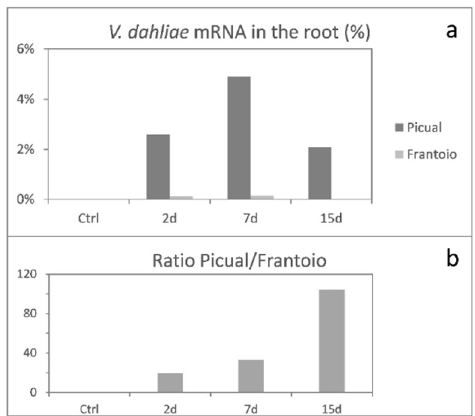
Figure 1. Accumulation of Verticillium dahliae transcripts in the roots of inoculated plants during early stage of infection in the susceptible variety ‘Picual’ and tolerant ‘Frantoio’. The percentage of the total paired-end reads that aligned with V. dahliae genes is represented for each time point. Only the paired-end reads that aligned both ends unequivocally at the correct distance with fungal genes are represented ( a ). Ratio of Picual/Frantoio percentage of reads is represented for each time point ( b ). 3.2. An Overwhelming Number of Verticillium Dahliae Unigenes Are Only Induced in Roots of the Susceptible Cultivar